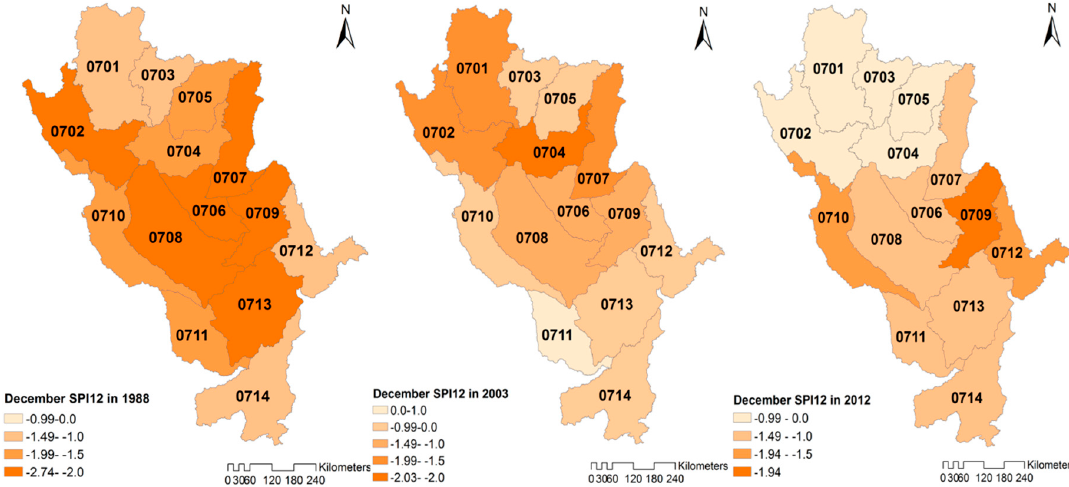
Figure A2. Spatial distributions of December SPI 12 for three representative drought years (1988, 2003, and 2012).